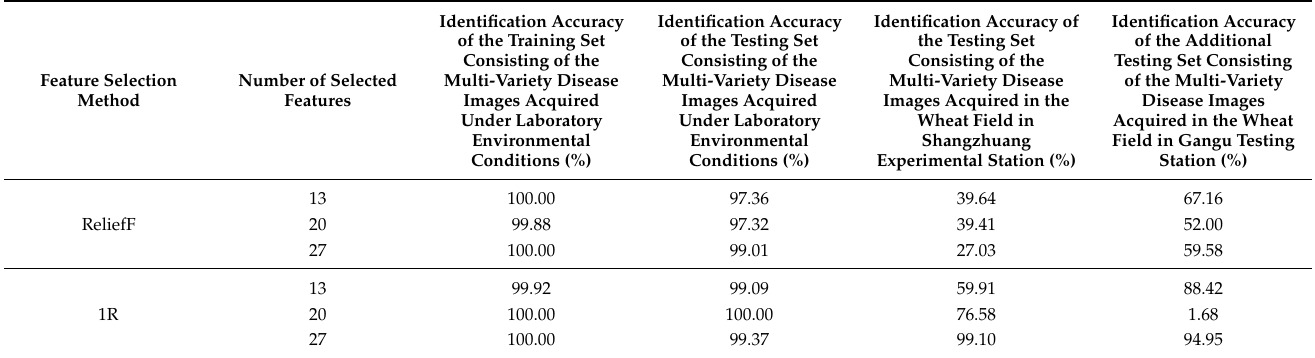
Table 10. Disease identification results of the RF models built with features selected based on the multi-variety disease image dataset consisting of images acquired under laboratory environmental conditions using feature selection methods including ReliefF and 1R,